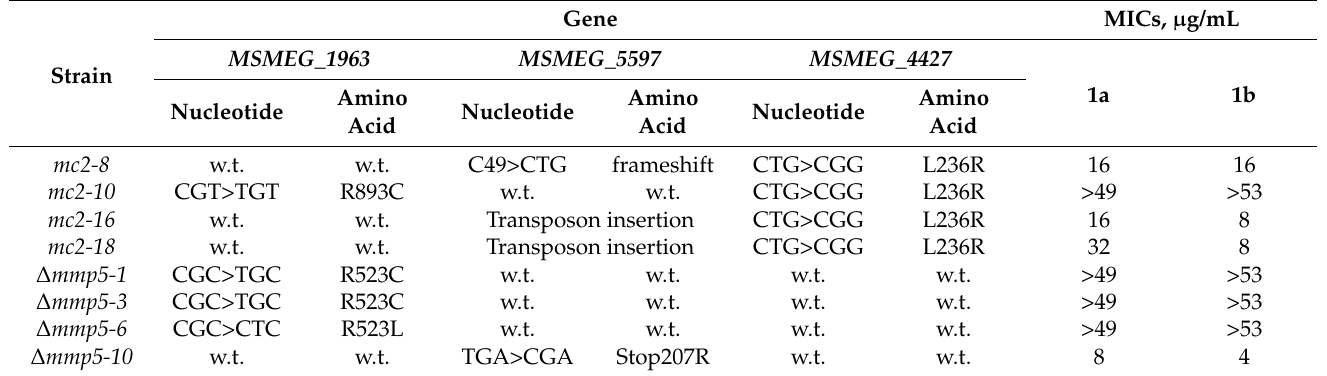
Table 2. Genetic and phenotypic characteristics of M. smegmatis mutant